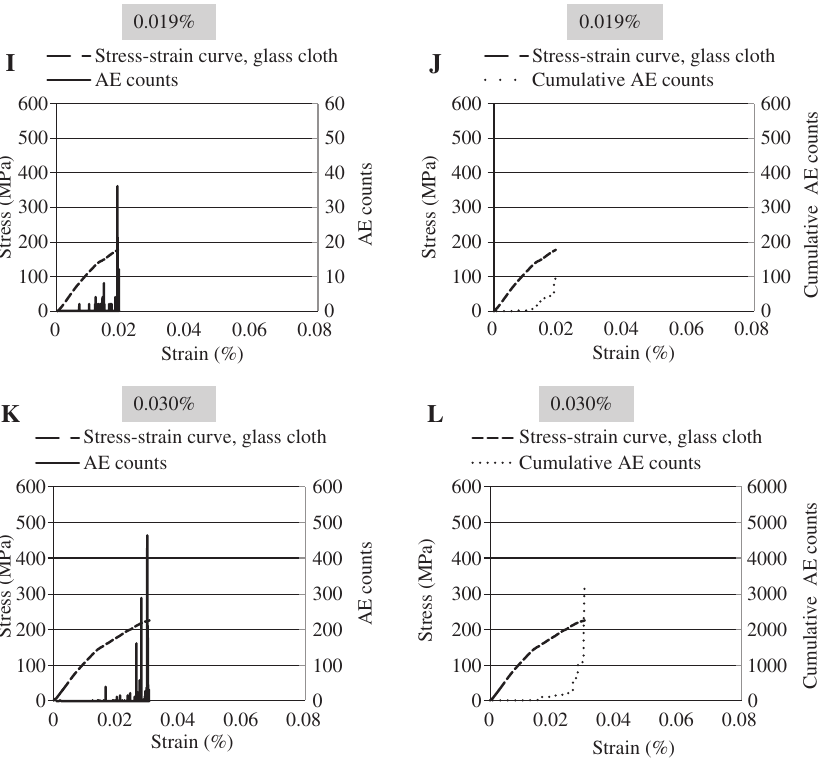
Figure 7 Stress-strain and AE events of specimens with various strains: (A–F) glass roving and (G–L) glass